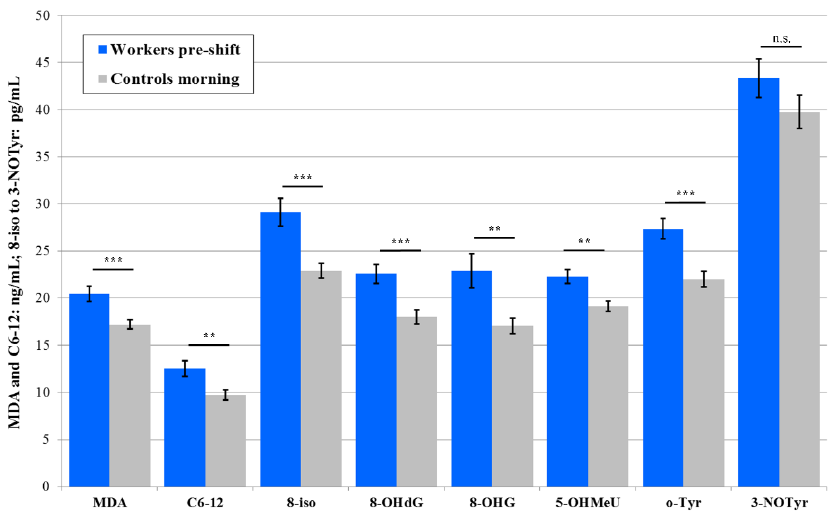
Figure 7. Mean and standard deviation of the levels of eight markers of oxidative stress in the EBC of all 29 workers pre-shift and in all 39 control subjects in 2016, 2017 and 2018; each person is included once only (a mean of repeated marker values), ** p < 0.01, *** p < 0.001, n.s. = not significantly different, EBC = exhaled breath condensate, MDA = malondialdehyde, C6-12 = aldehydes C6-C12, 8-iso = 8- iso -prostaglandin F2α (8-isoprostane), 8-OHdG = 8-hydroxy-2-deoxyguanosine, 8-OHG = 8-hydroxyguanosine, 5-OHMeU = 5-hydroxymethyl uracil, o-Tyr = o -tyrosine,